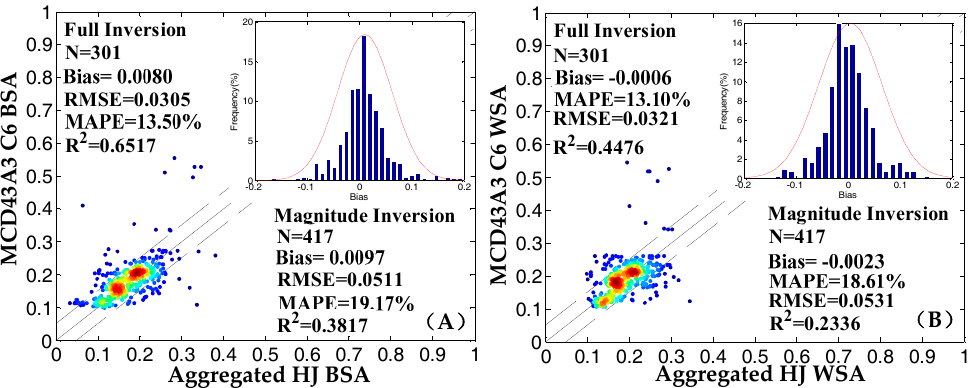
Figure 10. Coarse scale MCD43A3 C6 albedos validation by comparison with the aggregated coarse scale albedos: ( A ) the aggregated coarse scale BSAs vs. the MCD43A3 C6 BSAs; ( B ) the aggregated coarse scale WSAs vs. the MCD43A3 C6 WSAs. The colors refer to the density of points (from highest (red) to lowest (blue).